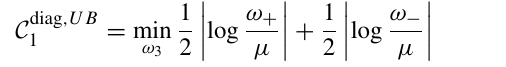
using unitary operations with minimal complexity. This is always possible since the two states have the same